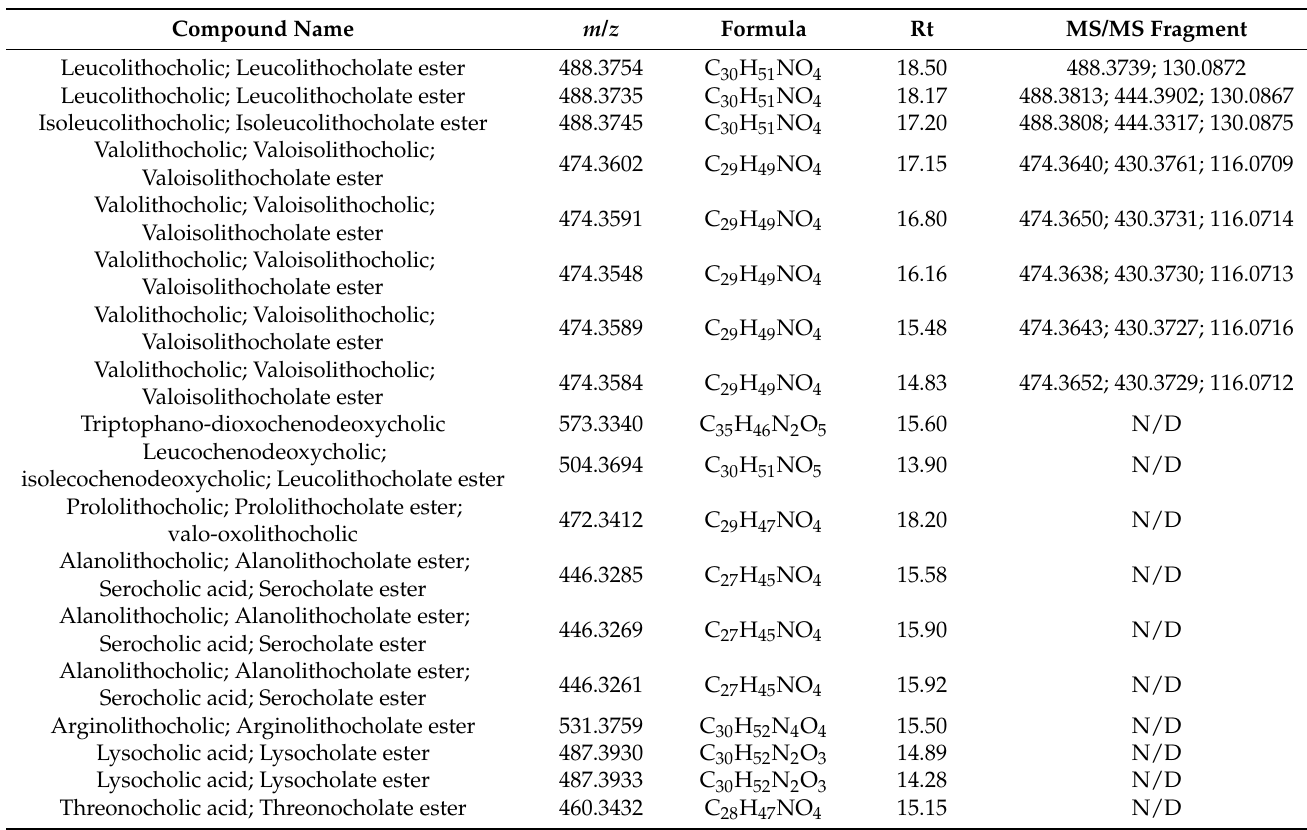
Table 2. Microbially conjugated BAs identified and confirmed.